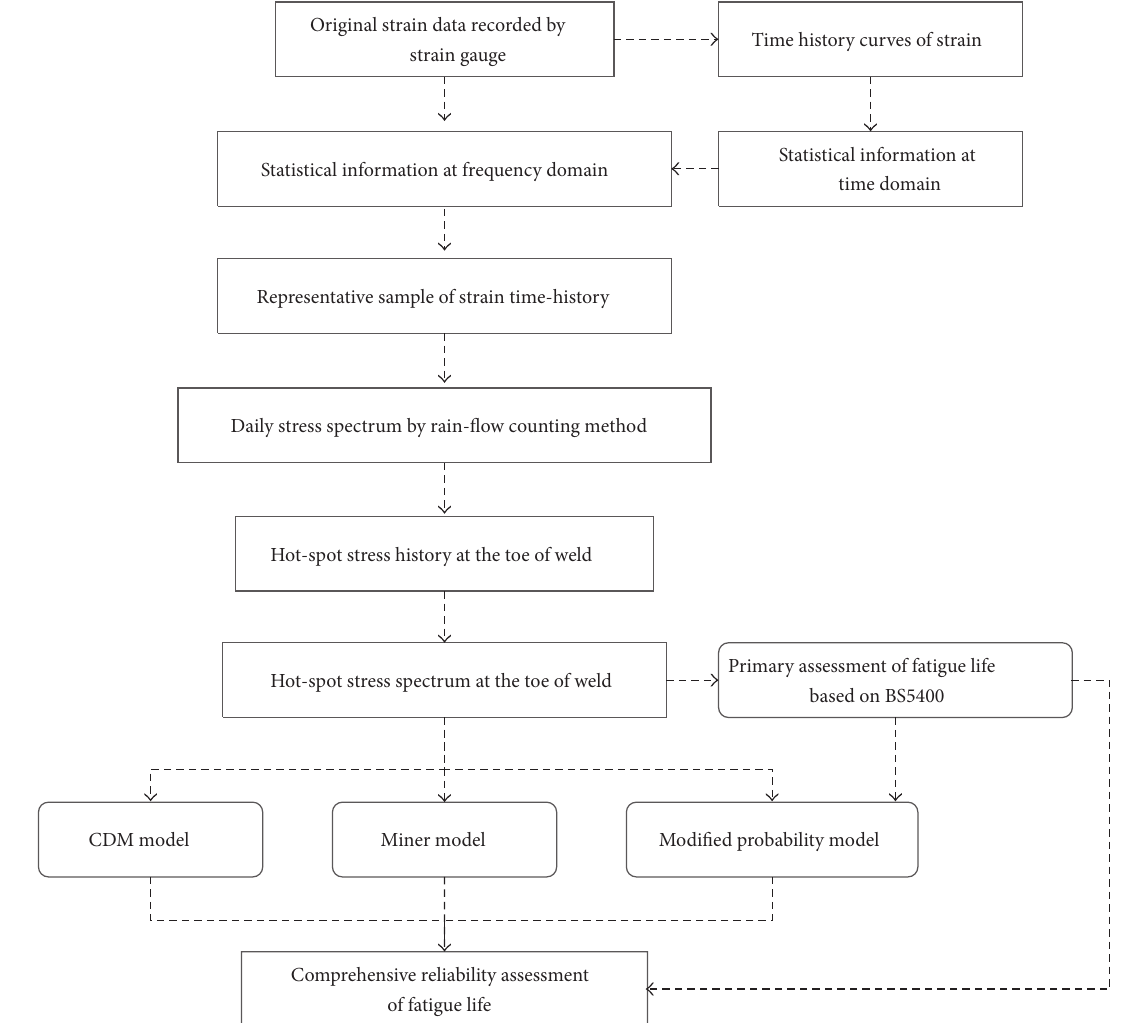
Figure 19: Structural fatigue assessment of